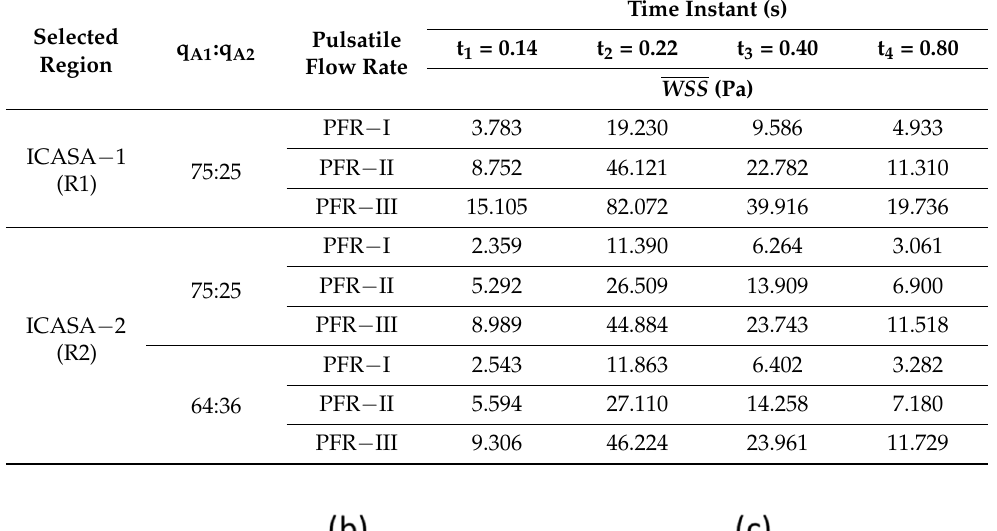
Table 3. WSS (Pa) in aneurysmal regions (R1 and R2) under selected instants and boundary conditions.